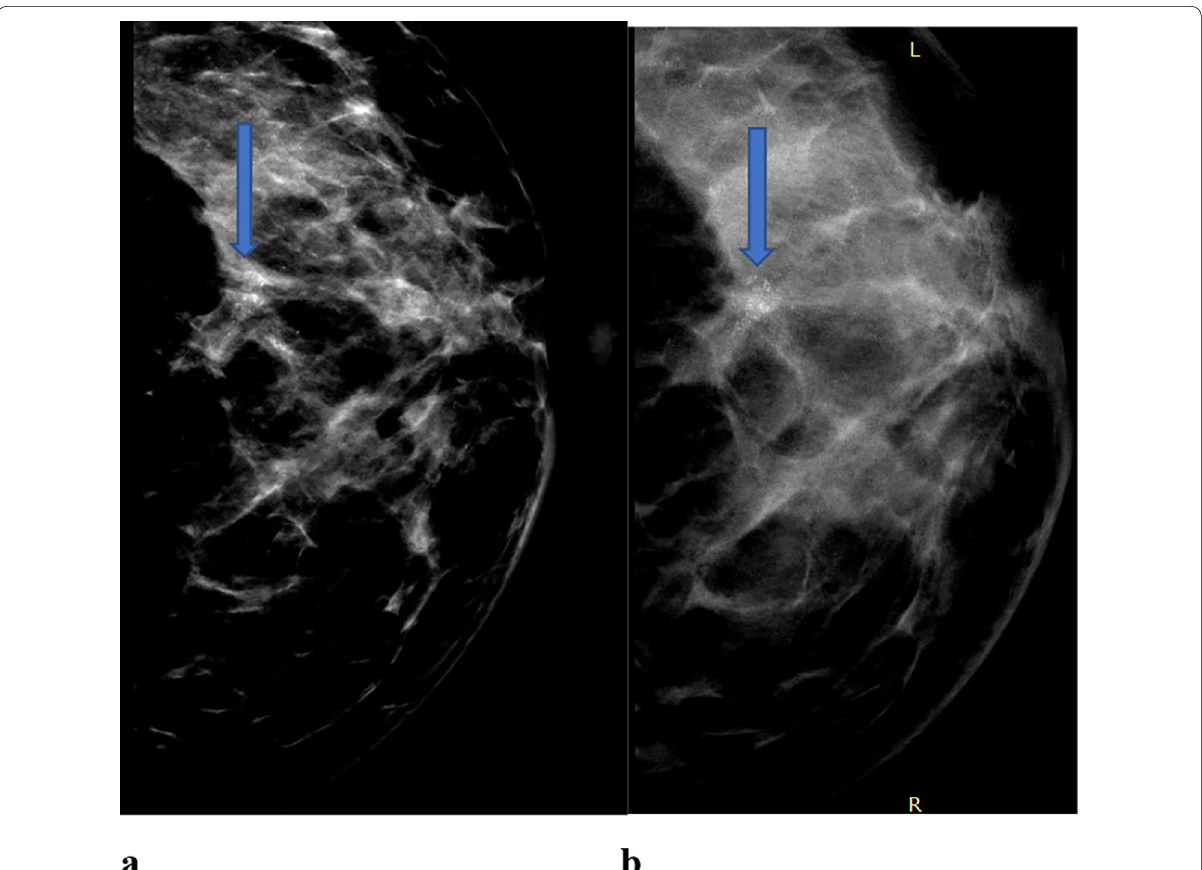
Fig. 10 A 34-year-old female came for screening with positive family history (first degree relatives) for breast cancer. a CC view of 2DDM of the left breast shows Scattered fibro-glandular densities (ACR b). b CC view of DBT of the left breast. The left breast shows group of fine pleomorphic microcalcification in the outer quadrant which is noted the same in both modalities. BIRADS 4, proved by histopathology to be ductal carcinoma in situ